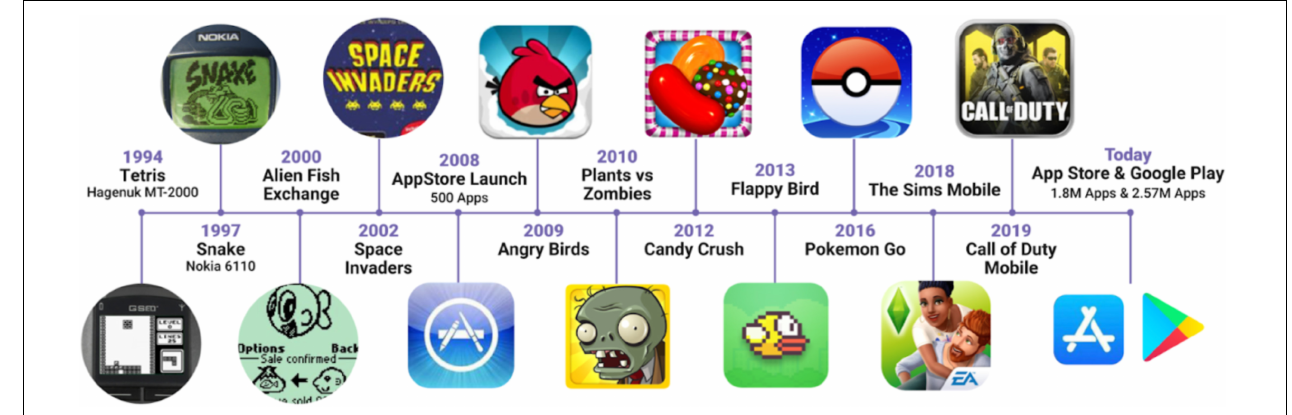
FIGURE 1 | Representative mobile games from 1994 to